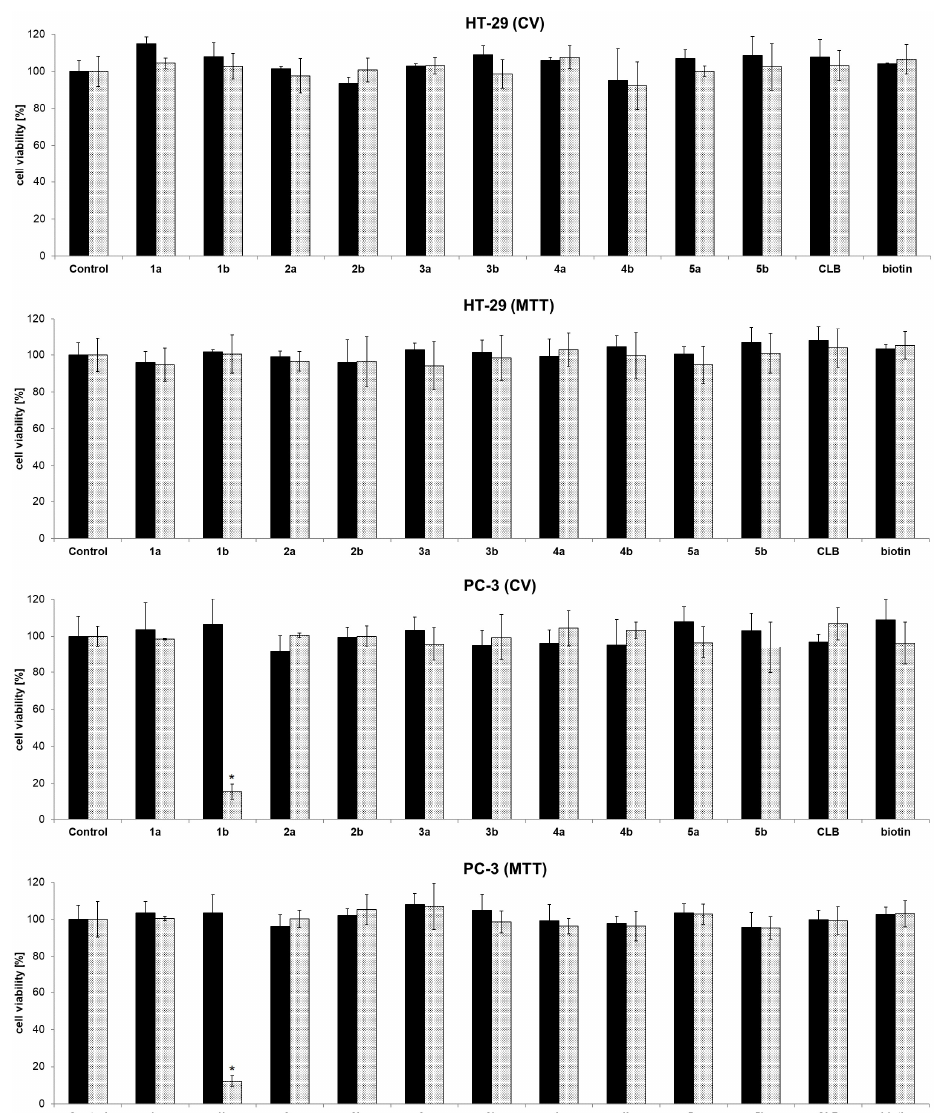
Figure 1 . Fast screening of cell viability of control (vehicle without dendrimer), dendrimers 1a / b – 5a / b , chlorambucil (CLB), and biotin determined by CV and MTT assays against HT-29 and PC-3 cancer cell lines (72 h of action; █ 0.01 µM; ░ 10 µM) [33], * p < 0.05 refers to untreated cultures.